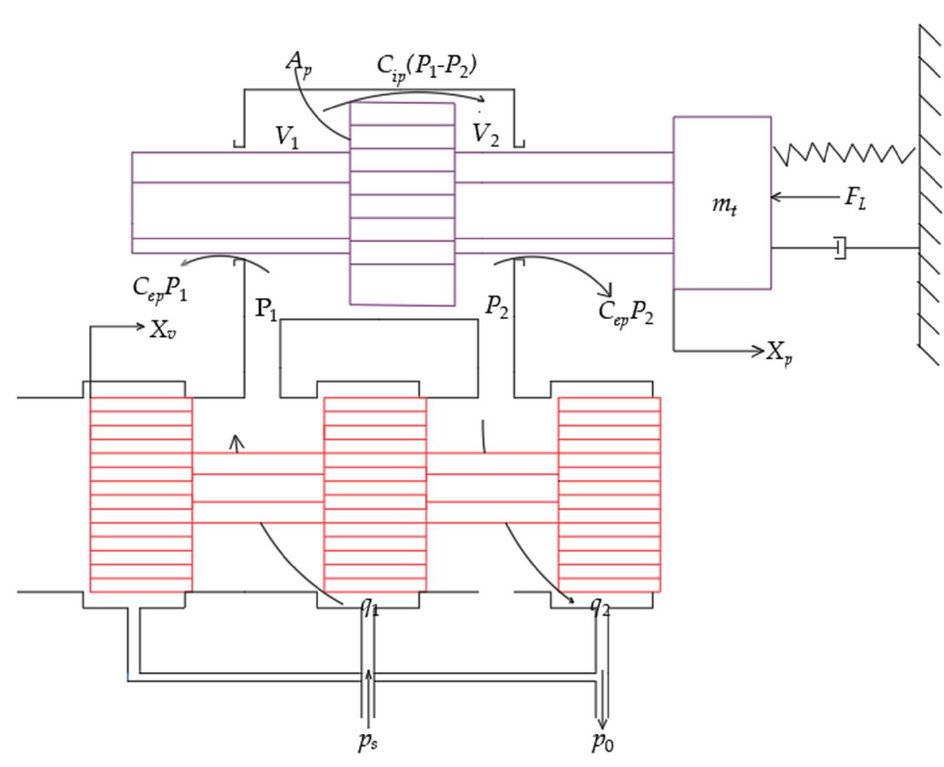
Figure 2. Valve-controlled hydraulic cylinder schematic.